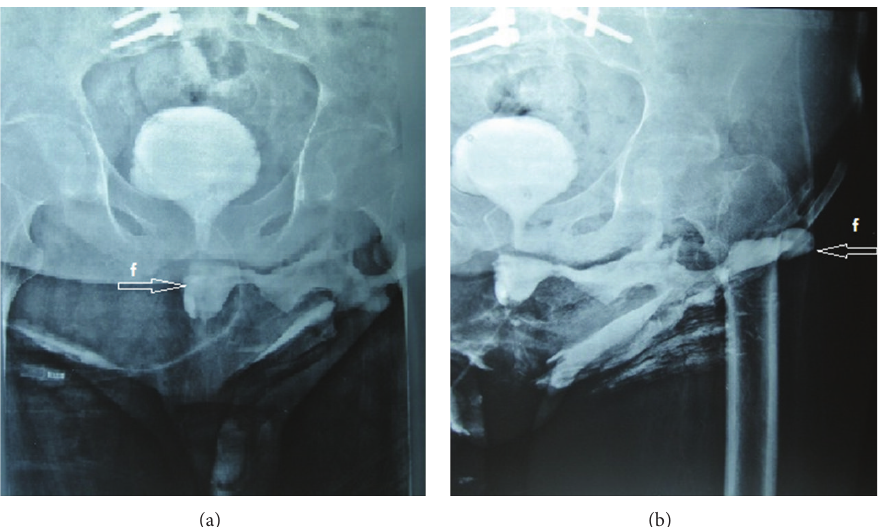
Figure 2: In cystourethrography, fistula tract and urinoma filled from a defect in the urethra were observed; f: fistula